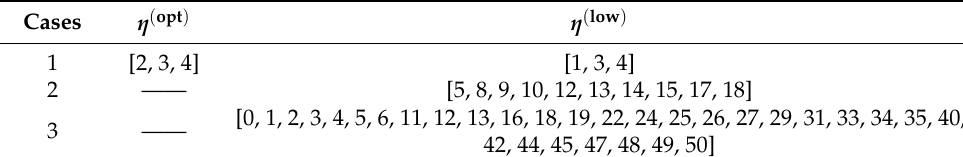
Figure 4. Error performance for DGRSC − STBC − SM using C S ( 10, 5, 6 ) and C R ( 10, 3, 8 ) under different selection algorithms, N t = 4 and BPSK. Table 10. Optimized selection patterns corresponding to three different cases.